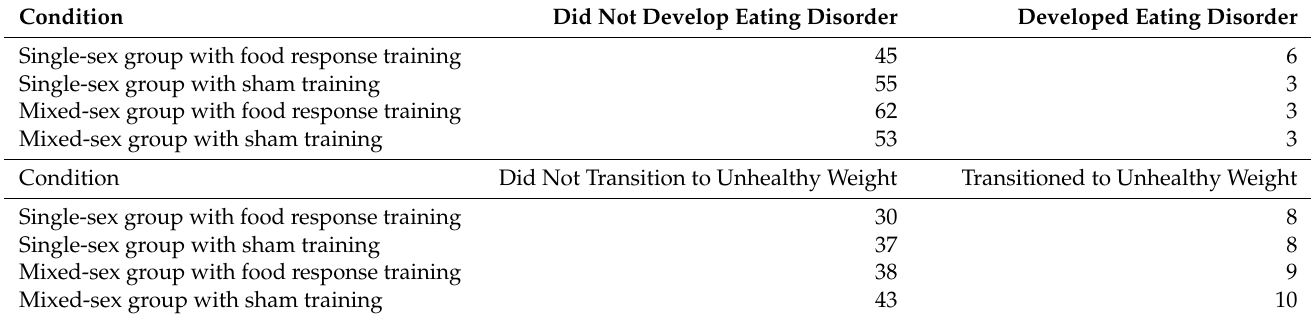
Table 4. Onset of any Eating Disorder or Overweight/Obesity during the Study by Table 1. Descriptive Summary for Study Variables by Condition.